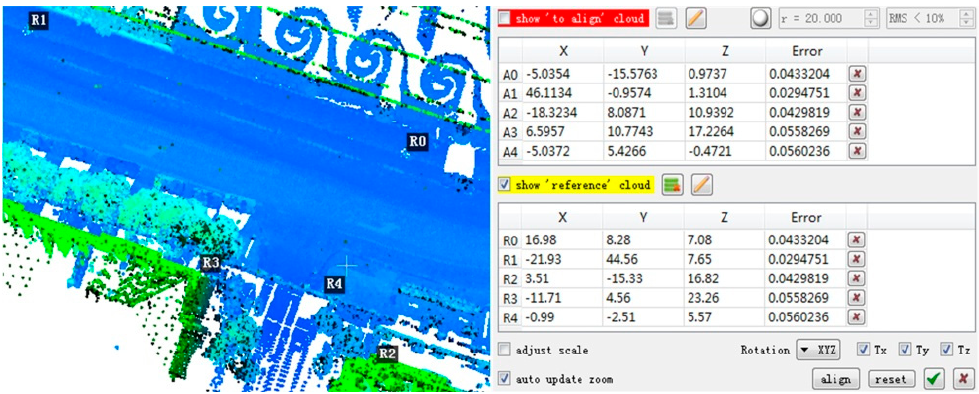
Figure 7. The rough matching for dataset 2 by software CloudCompare.